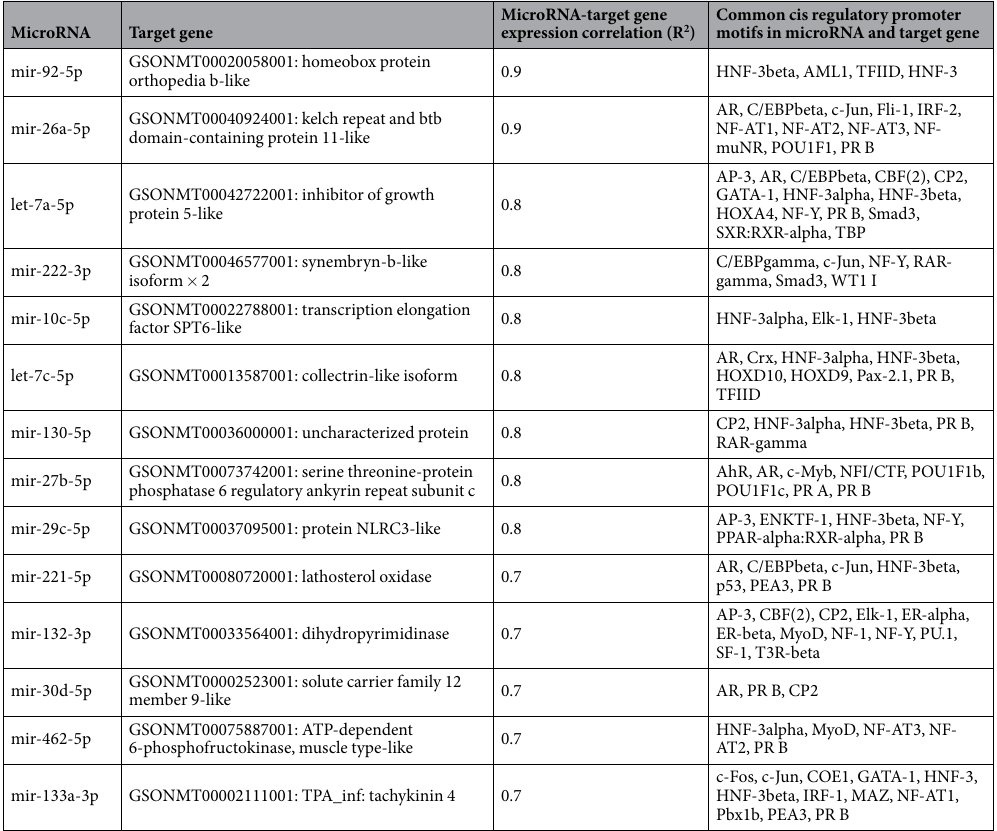
Table 4. Cis-regulatory transcription factor binding motifs that exist in promoter sequences of differentially expressed (DE) microRNAs and their positively correlated target